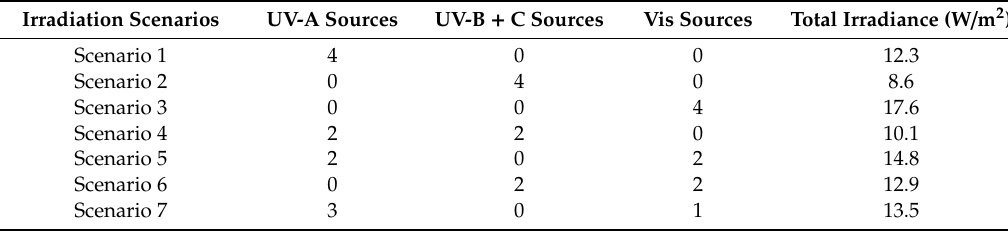
Table 1. Irradiation scenarios